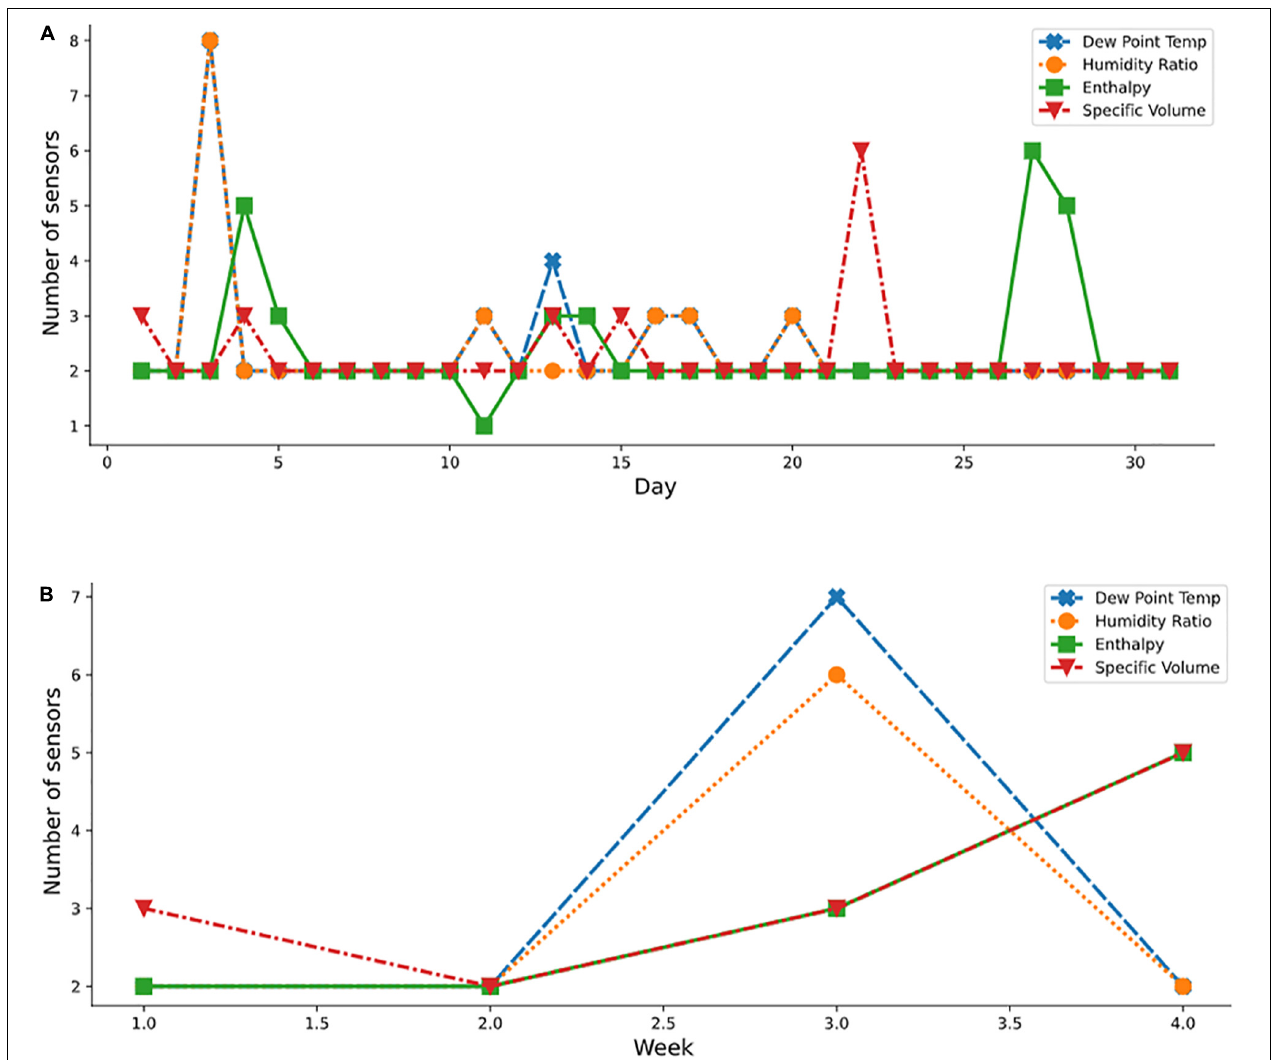
FIGURE 10 | Optimal sensor selection for summer month using the psychometric dataset; (A) July daily; and (B)